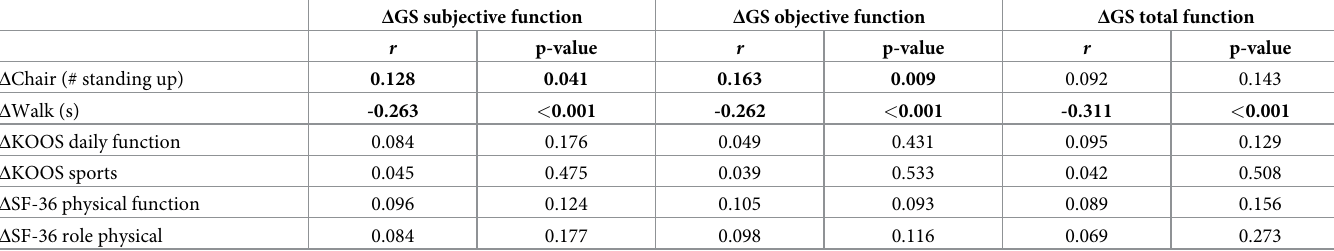
Table 4. Pearson’s correlation coefficients between changes from baseline to M6 for all used functional outcome measures.